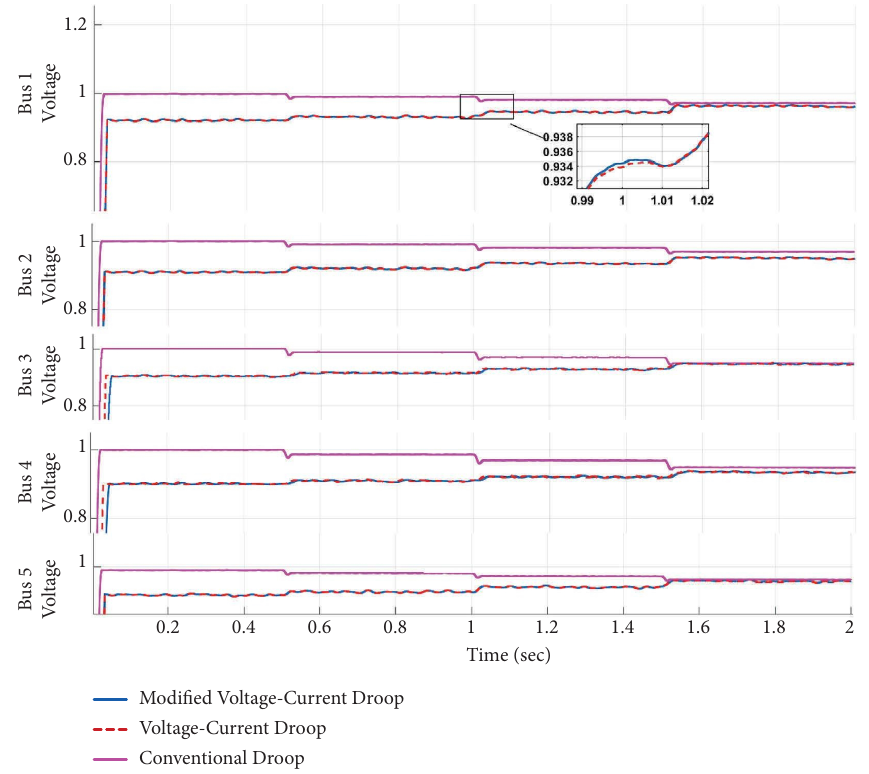
Figure 9: Representation of voltage of 5 bus microgrid test